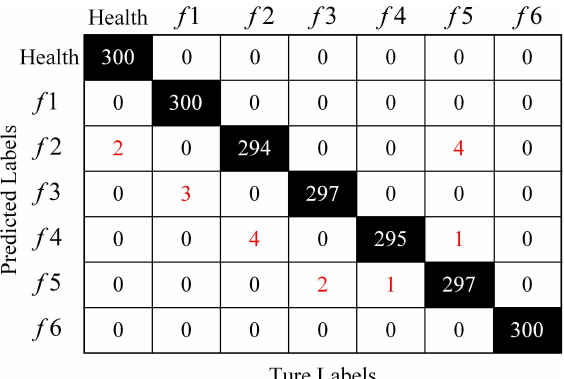
Figure 9. Confusion matrix of proposed